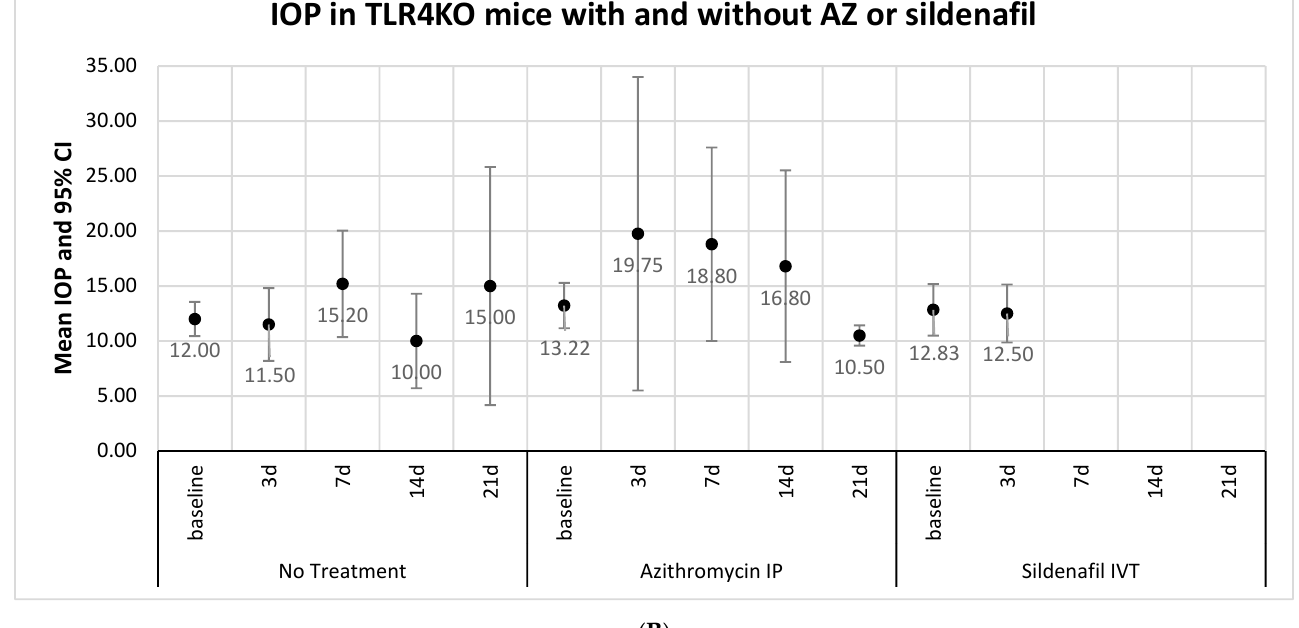
Figure 2. ( A ) Comparison of IOP measurements between treated and untreated groups: WT mice. Analysis of eyes injected with microbeads and either untreated ( n = 8) or treated with intraperitoneal AZ ( n = 20), intravitreal sildenafil ( n = 5), or intraperitoneal sildenafil ( n = 17). The results shown in the figure are based on between 3 and 15 eyes for each measurement. IOP decreased in systemic untreated eyes during follow-up. IOP was variable in AZ-treated eyes, peaking at 2 weeks. In sildenafil- treated eyes, IOP peaked on day 7 and then decreased. IOP, intraocular pressure; IP, intraperitoneal; IVT, intravitreal. ( B ) Comparison of IOP measurements between treated and untreated groups: TLR4KO mice. Analysis of eyes injected with microbeads and either untreated ( n = 11) or treated with intraperitoneal AZ ( n = 9). The results of 3–15 eyes for each measurement are shown. IOP increased in AZ-treated eyes on days 3, 7, and 14.